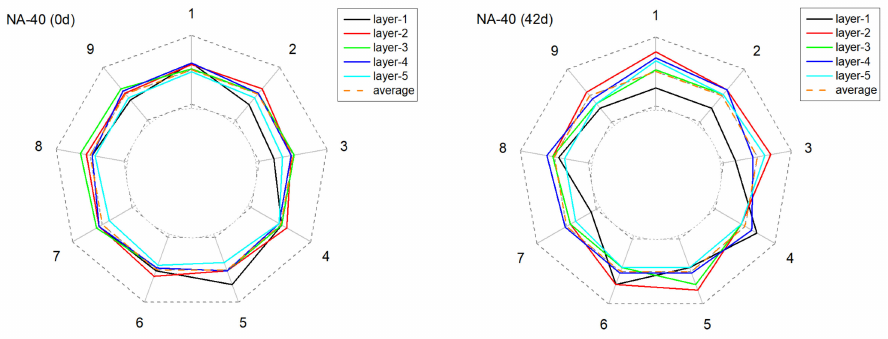
Figure 11. The deviation of the current from the mean value of current over time at different positions in the anode sample during the AAT (NA-40).